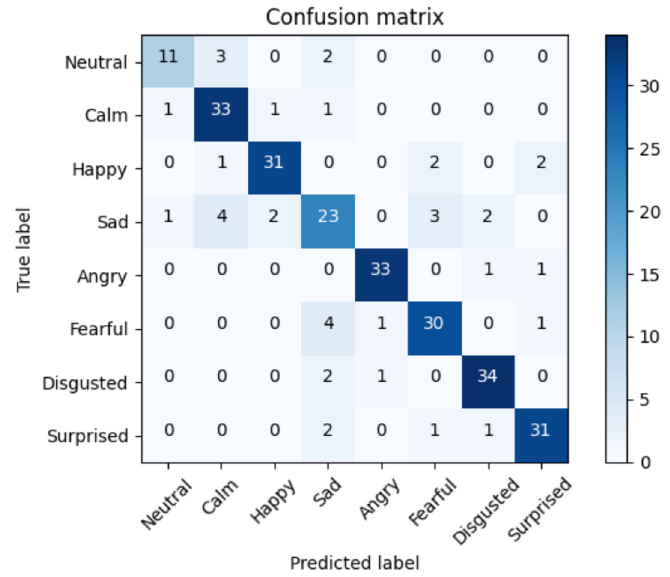
Figure 15. Average confusion matrix for RNN-LSTM approach. Accuracy = 91%.